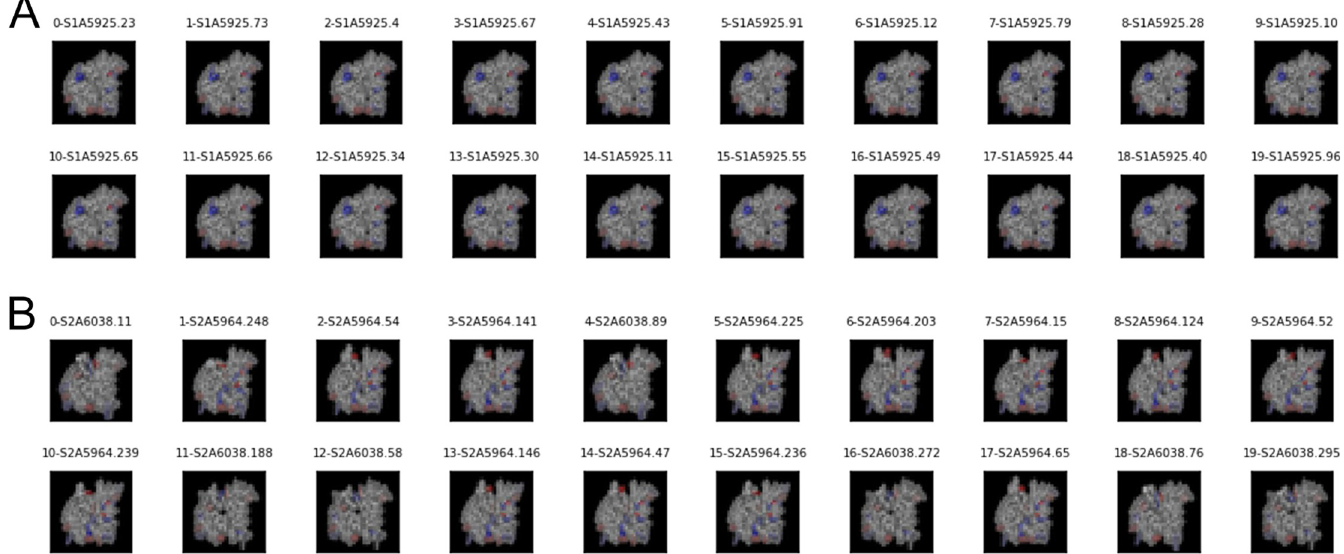
Fig 8. Representative Ab fingerprints from normal and outlier classes. (A) Exemplar images of Ab fingerprints classified as belonging to lineage 1 by one DNN model. The images from panel A are ordered according to scores assigned by the neural network. They are organized in rows of 10 images, with scores decreasing from left to right. (B) Exemplar images of Ab fingerprints classified as belonging to outliers (Abs from lineages other than 1) by the DNN model. The images from panel B are ordered according to scores assigned by the neural network. They are organized in rows of 10 images, with scores increasing from left to right. These results correspond to the DNN model listed as “3” in Table